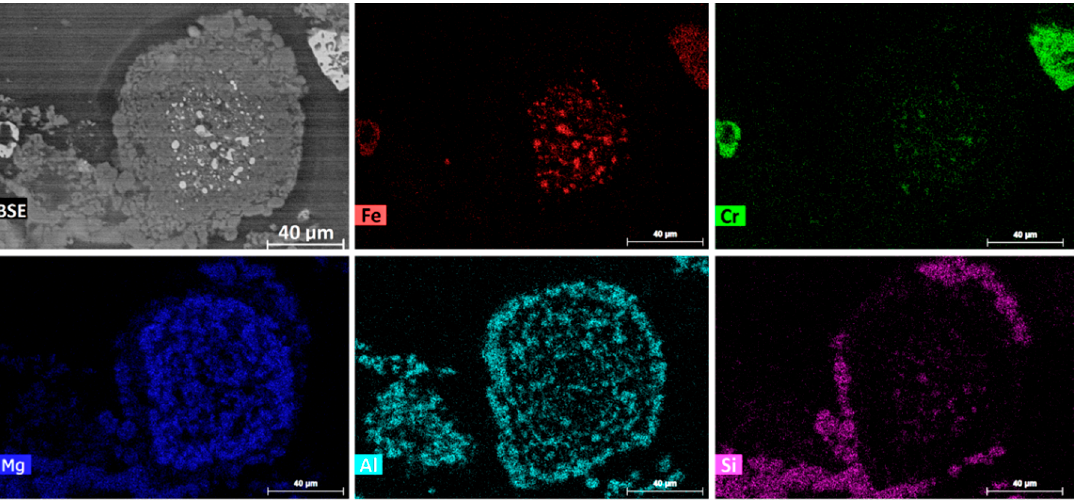
Figure 4. BSE and elemental mapping of a reduced chromite particle (75–105 µm) in which discrete Fe-rich ferrochrome alloy particles are present.